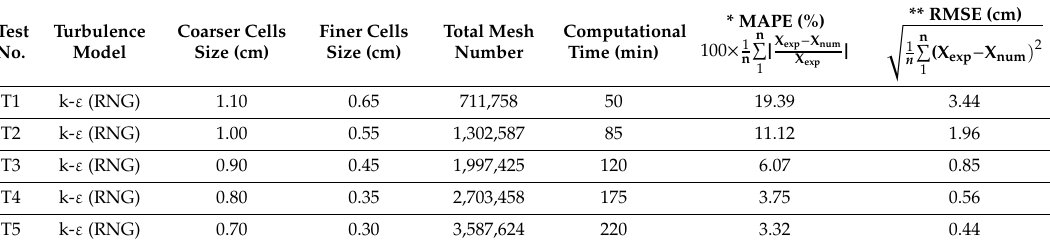
Table 2. Mesh sensitivity analysis for the present study.